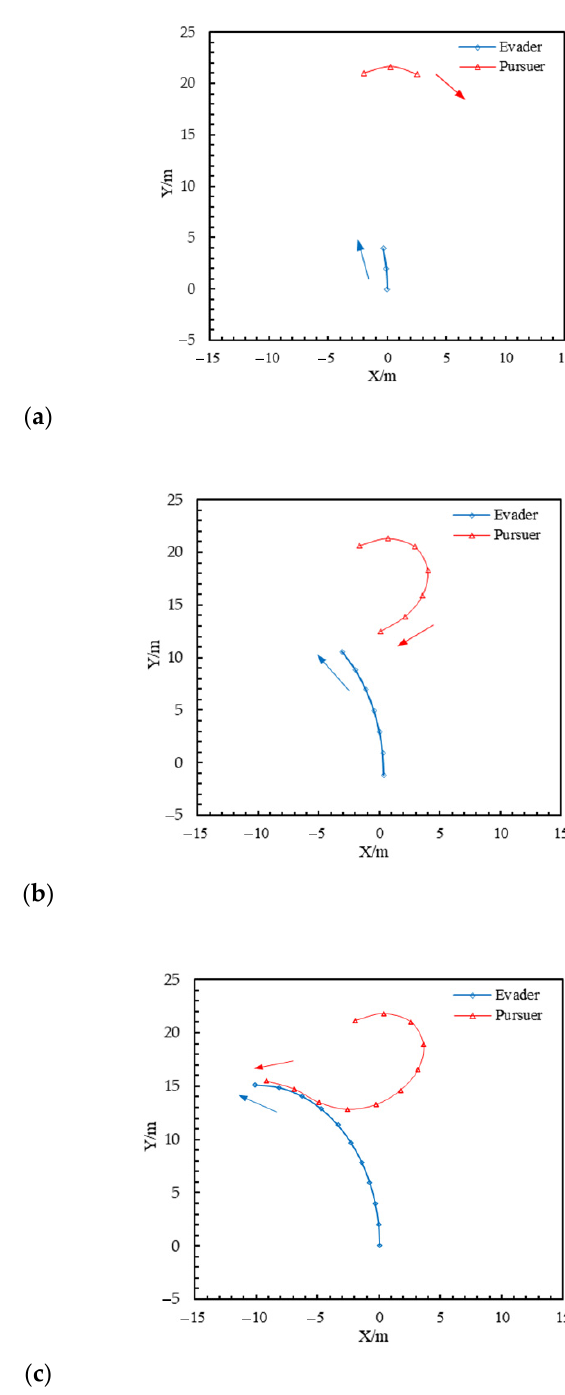
Figure 11. Experimental results of the pursuit trajectory. ( a ) The pursuer sensed the evader and began to intercept it. ( b ) The pursuer gradually approached the evader. ( c ) The pursuer successfully intercepted the evader.